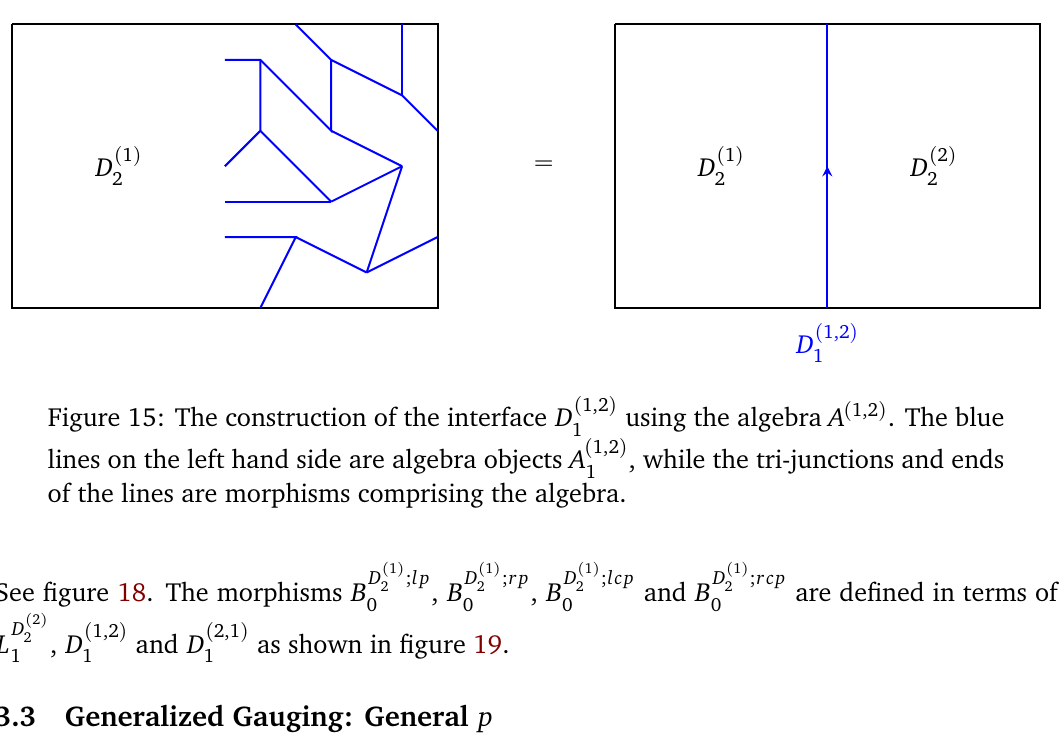
Figure 14: The construction of the topological defect D p 2 q on D p 1 q . The blue lines on the left hand side are algebra objects A p 1,2 q 2 tri-junctions are morphisms comprising the algebra.